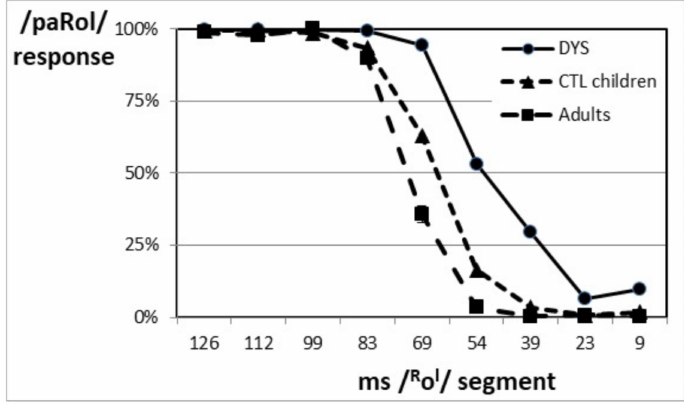
Figure 3. Identification functions of the whole samples of DYS and CTL children, and of CTL